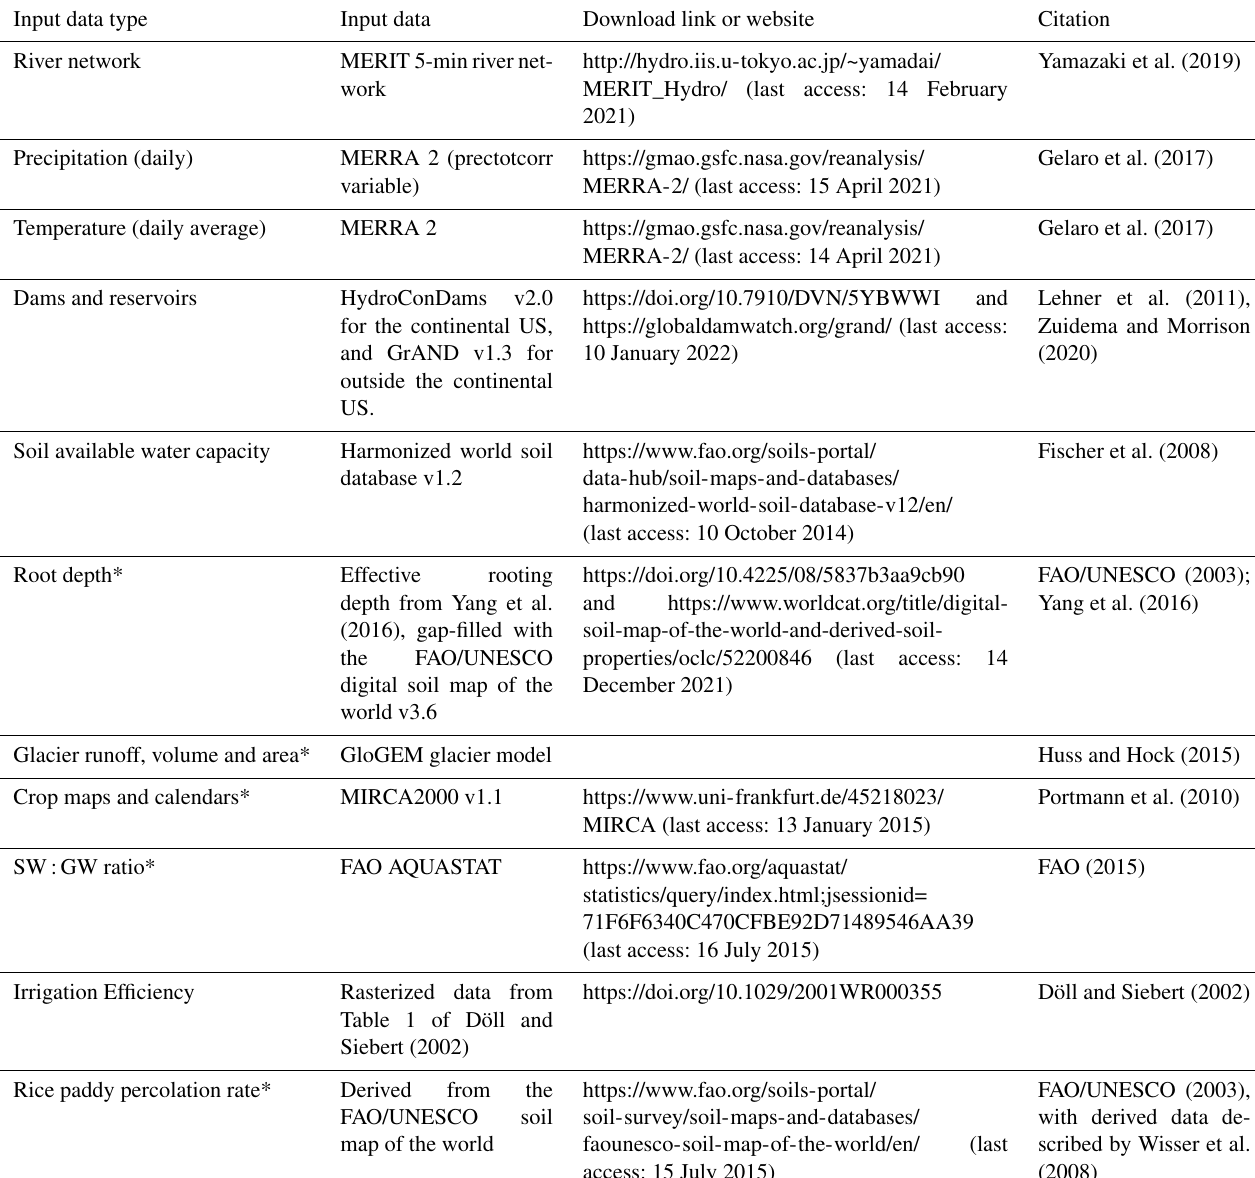
Table 4. Model input datasets for WBM simulations presented